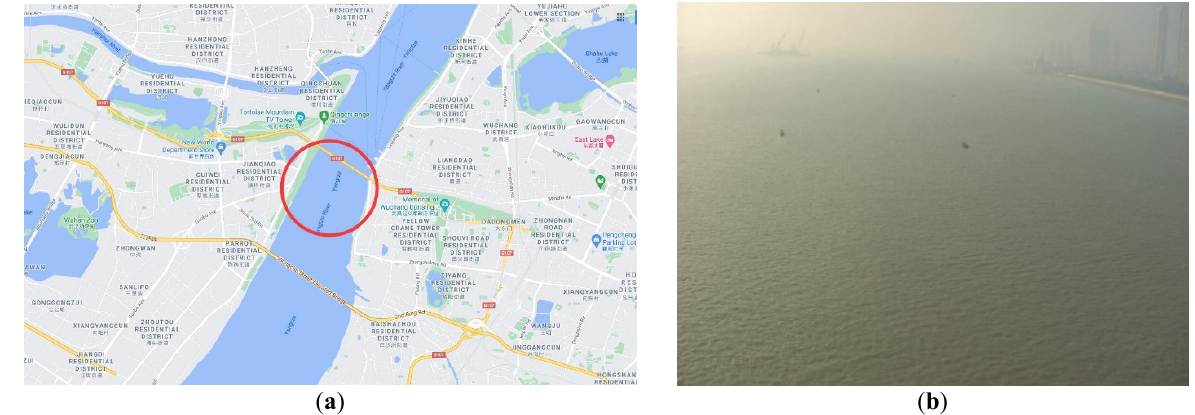
Figure 2. Selection of experimental scene: ( a ) experimental location, ( b ) experimental scene image.